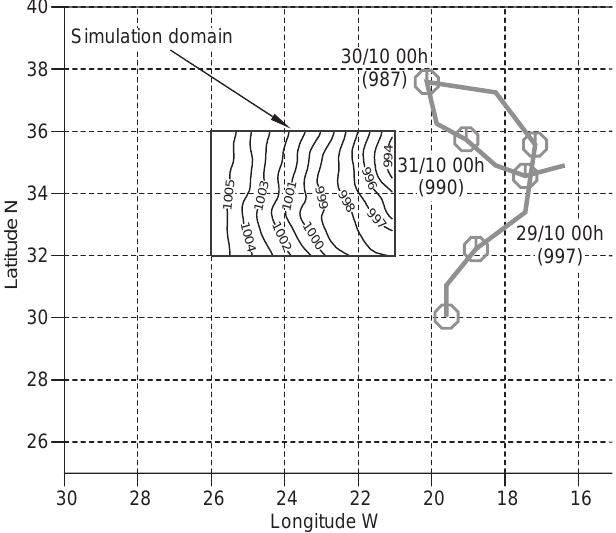
Fig. 1. Transfer coe(cid:129)cients as a function of U 10 n . The threshold values for the smooth flow regime and for the rough flow regime are 5.2 m/s for C hn and C en and 5.5 m/s for C dn